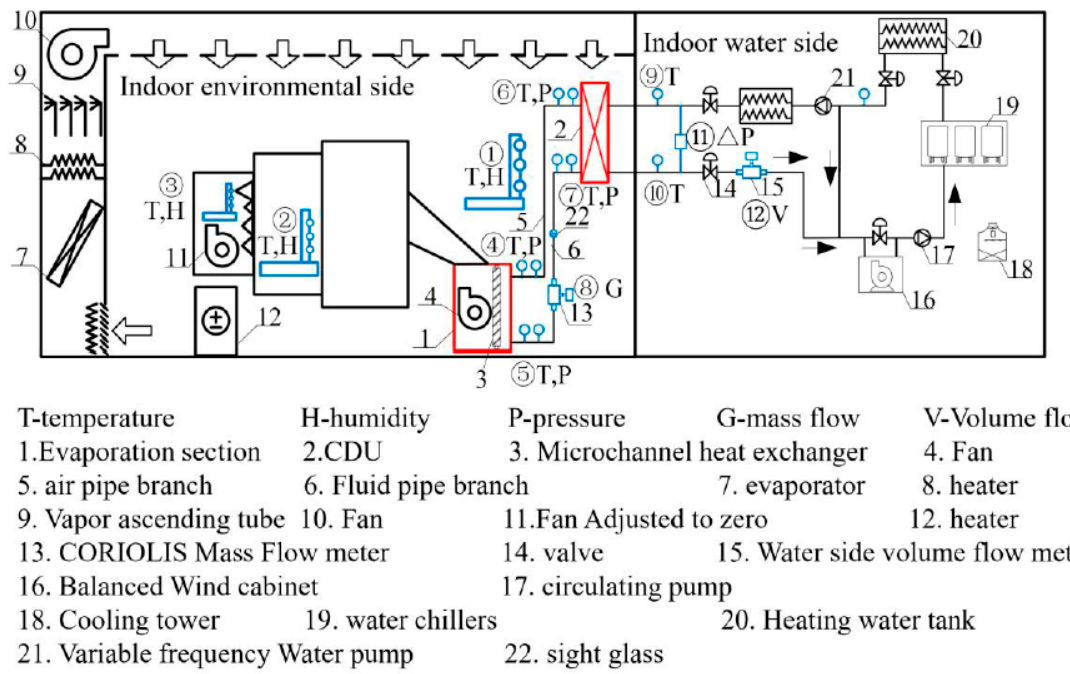
Figure 2. Schematic diagram of backplane heat pipe test platform of enthalpy difference laboratory.